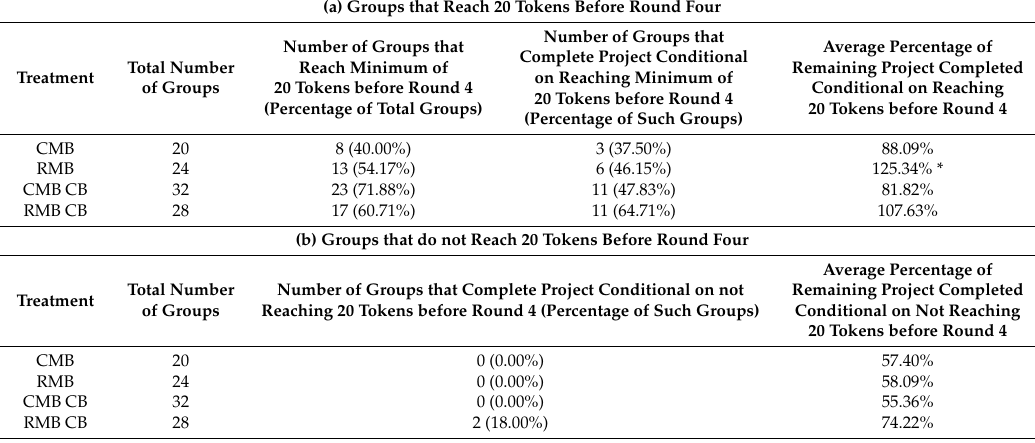
Table 5. Later Round Behavior and Project Completion Conditional on Contributions in the First Three